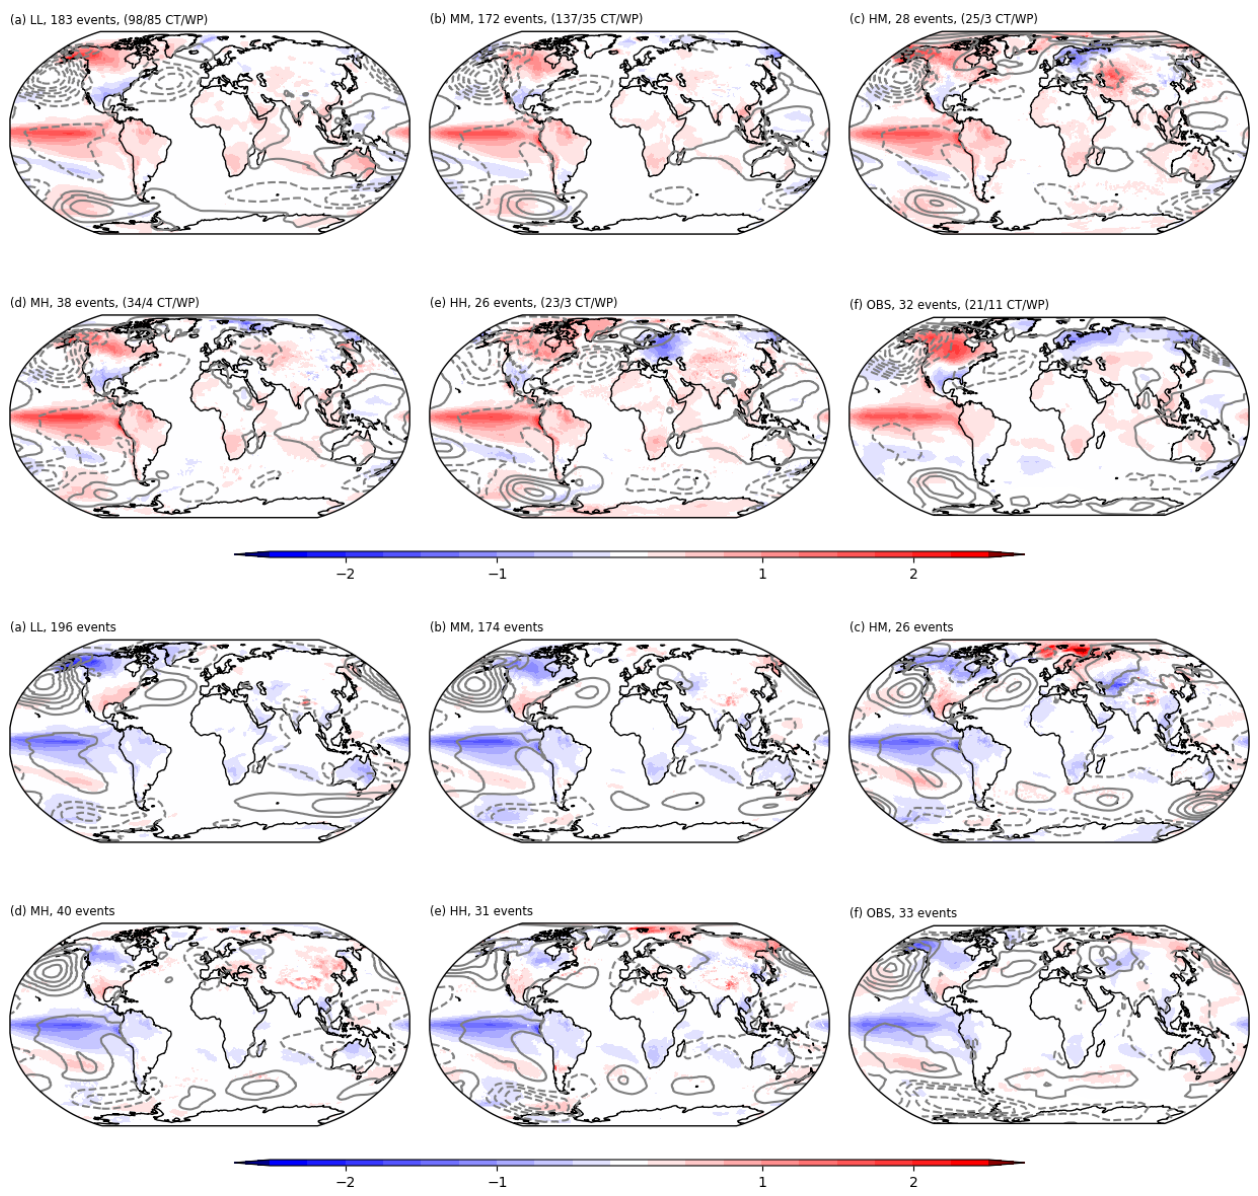
Figure 20. Composite DJF mean surface temperature (colours) for (top) El Niño and (bottom) La Niña from models and observations based on El Niño and La Niña events. The number of events sampled is shown in the title and the proportion of El Niño events classified as cold tongue (CT) and warm pool (WP). Events are defined as years when the NINO3.4 DJF SST anomaly exceeds 0.7K. The observations are a combination of HadISST1.1 over the ocean and CRU 2m temperatures over land, with values masked over HadISST1.1 sea ice regions. Mean sea level pressure anomalies are shown as contours with interval 0.5hPa, with observations from